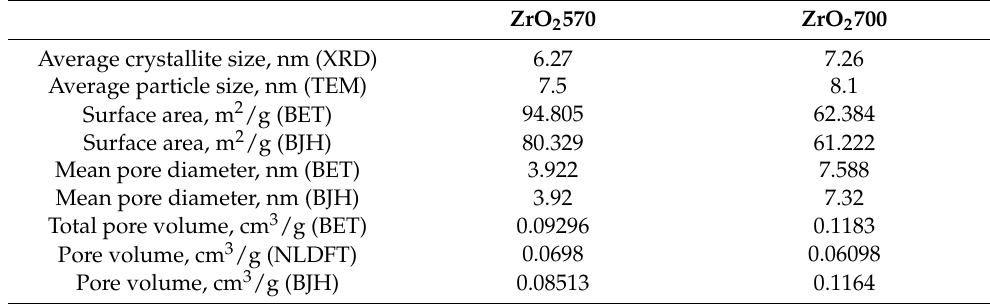
Table 1. Crystallite size, BET surface area, and pore dimensions of ZrO 2 NPs570 and ZrO 2